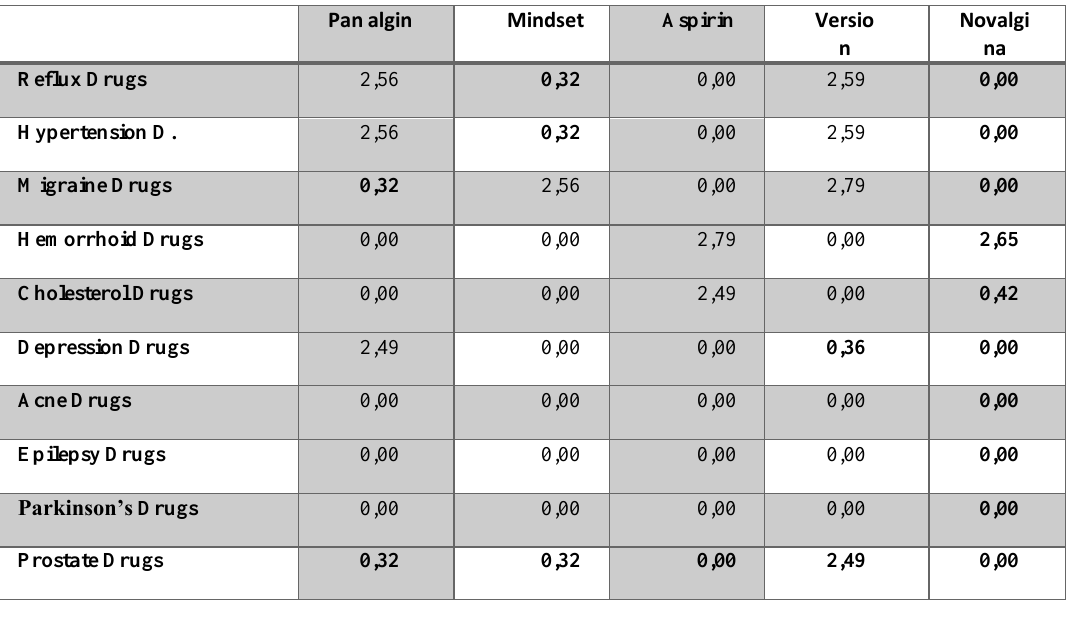
Pan algin Mindset Aspirin Versio